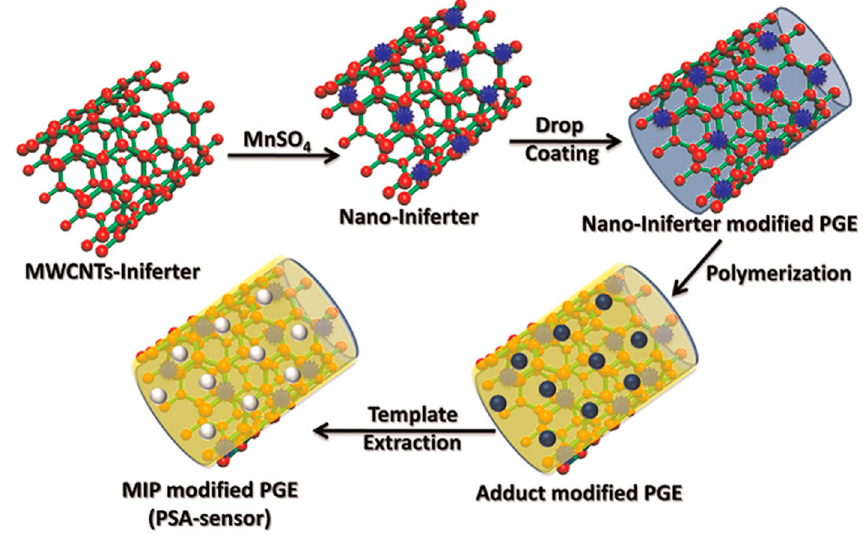
Figure 1. Schematic representation for the fabrication of the PSA sensor. Adapted with permission from [37]. ©2014 Elsevier.